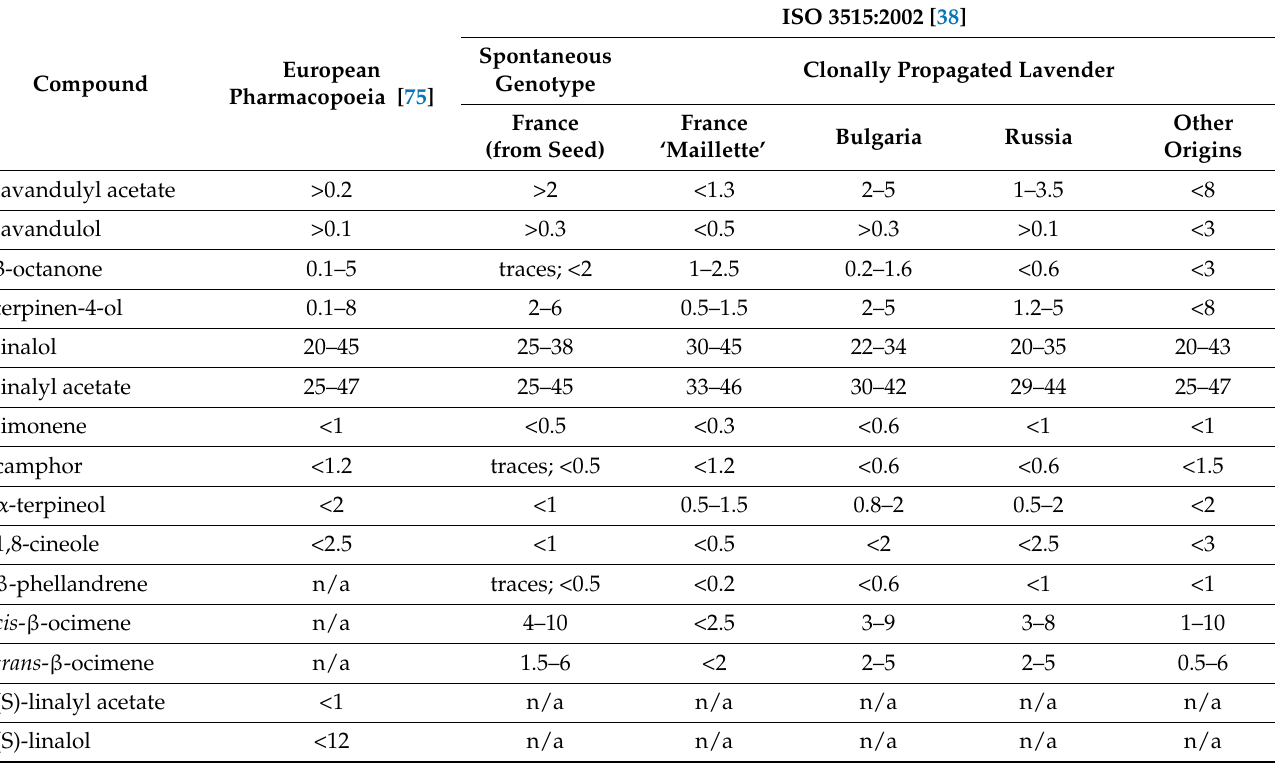
Table 3. Standards for L. angustifolia essential oil